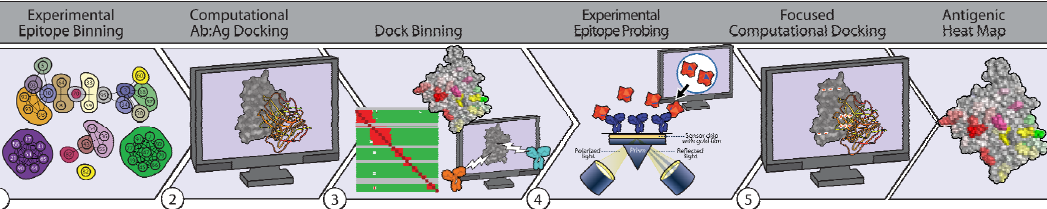
Figure 1. Schematic overview of our method for localizing Ab-specific epitopes by integrated experimental and computational analysis of binding competition. (Step 1) Experimental binning identifies communities of Abs that compete with each other for Ag binding. This grouping allows subsequent analyses to be focused on one or a few representatives from each community, reducing the e ff ort required. (Step 2) For each representative Ab, a homology model of its Fv structure is constructed from its sequence, and Ab:Ag docking models are generated from the Ab model and the Ag structure or homology model. (Step 3) The docking models are computationally clustered, with this dock binning process analogous to experimental epitope binning in identifying patterns of competition. Since the competition is in terms of structural models of Ab:Ag binding, the identified communities correspond to general antigenic regions, and thereby map out potential binding regions on the Ag, summarized across the whole Ab panel as an antigenic heatmap. (Step 4) Experimental data is collected to probe the hypothesized epitope regions, e.g., using site-directed mutagenesis, chimeragenesis, peptide binding, or selection of alternative natural variants, in order to alter a putative epitope and evaluate e ff ects on experimental competition or binding. (Step 5) The experimental data is used to focus docking, redefining bins, better characterizing competition, and better localizing epitope binding regions. This ultimately results in an antigenic heatmap localizing putative binding regions of the di ff erent Abs (illustrated by colored patches on the Ag surface).